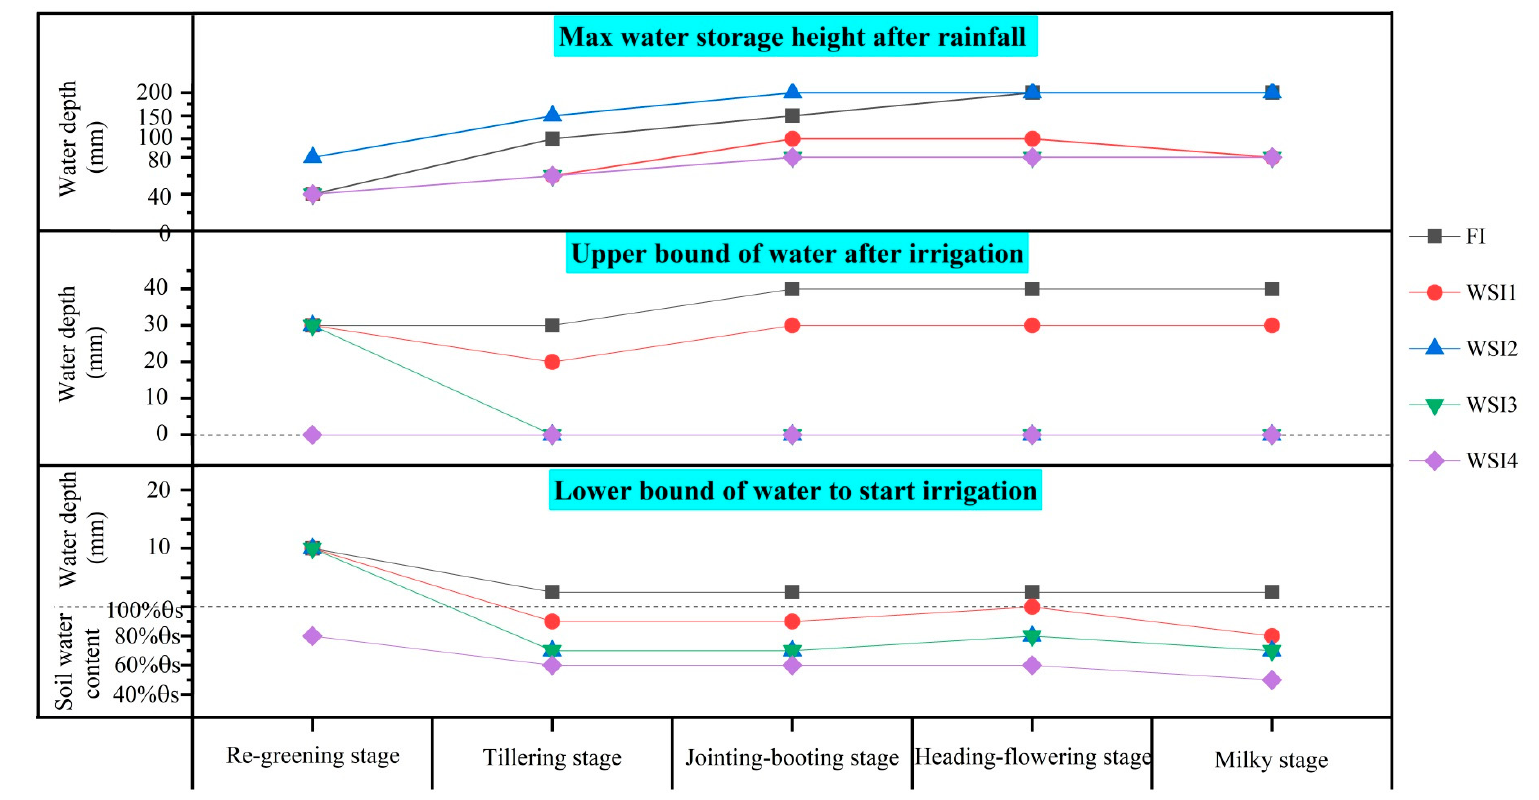
Figure 1. The water-controlled thresholds in different growth stages under different irrigation methods. ( θ s is the saturated water content for the 0~30 cm soil layers. There was a field sunning about five days in late tillering stage).